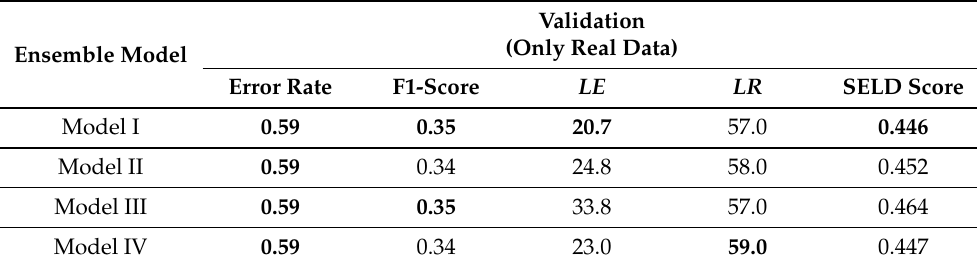
Table 3. Performance comparison of the ensemble models. The values that have the best performance are